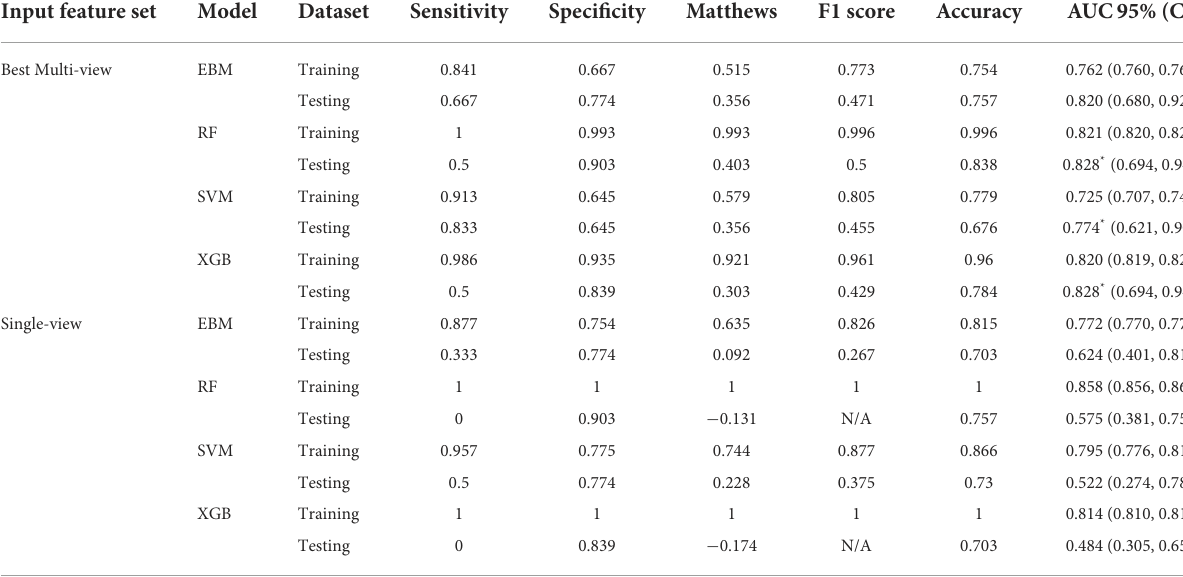
TABLE 2 Comparison of performances in pCR prediction for four different models built with features selected from Boruta using the best multi-view input (CP + DVH + S + R_L1 + R_L2), and the single-view input concatenated with full features (CP + DVH + R all + D all